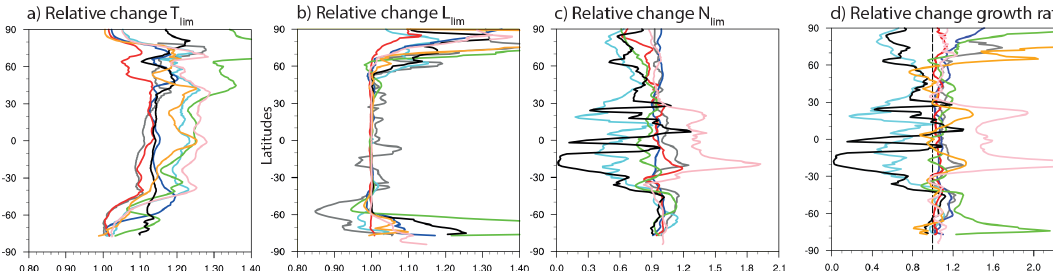
Figure 6. Zonal mean of the relative change in temperature, nutrient and light limitation and growth rate. For each model only the values for the phytoplankton PFT with the strongest temperature (or light or nutrient limitation factor or growth rate) response is shown. We calculate . A value of 1 means no change and is indicated by the dotted line. Different line colors denote the relative change as 2081–2100 average 2012–2031 average different models, as in the legend of Fig.